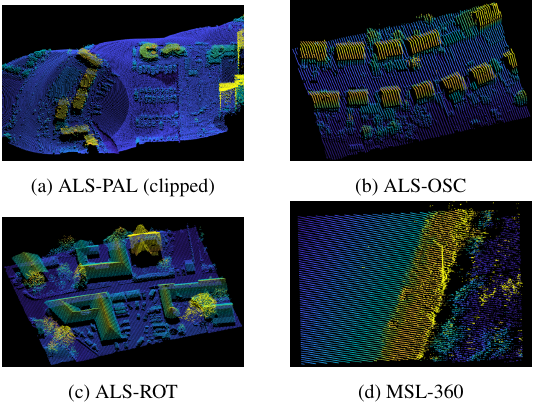
Figure 2. Height color coded 3D view of the test